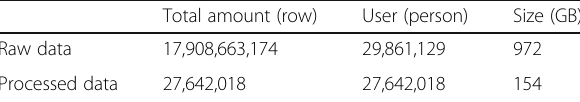
Table 2 Comparison of data before and after pre-processing